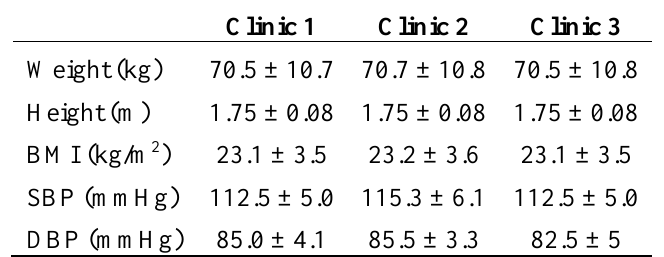
Table 4. The anthropometric, BMI and BP results for the four participants at each clinic